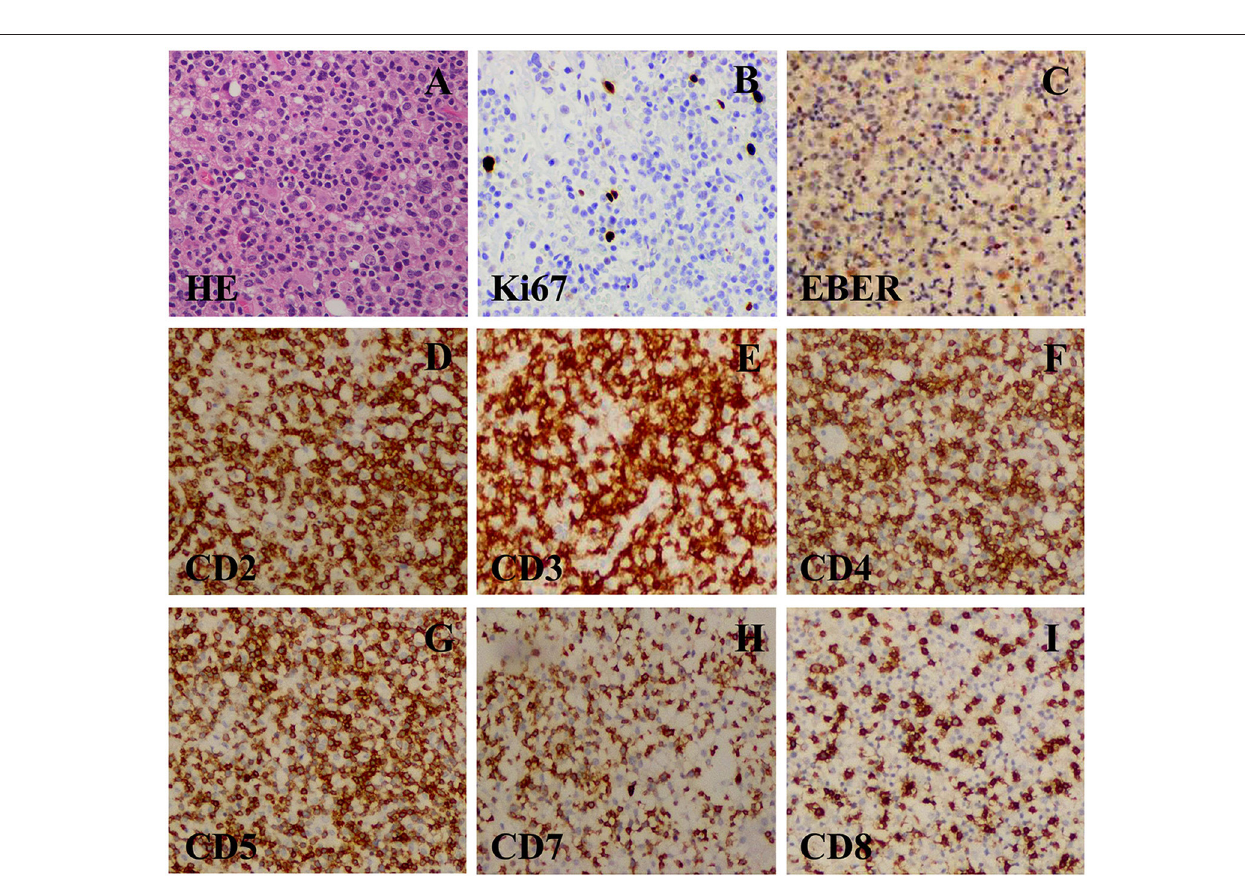
Frontiers in Surgery |